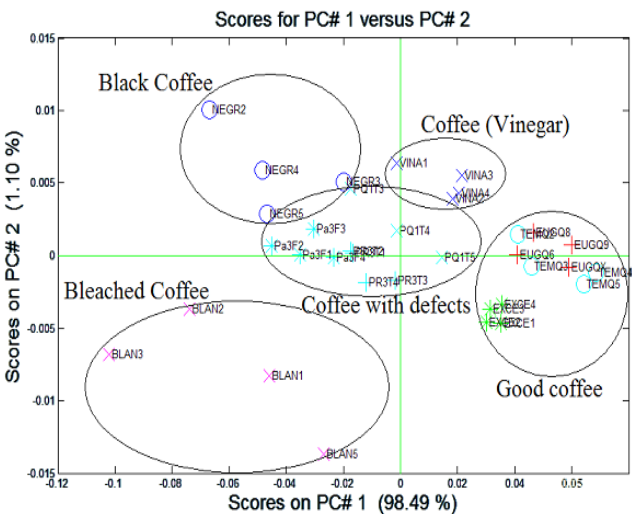
Figure 9. PCA graph with more types of